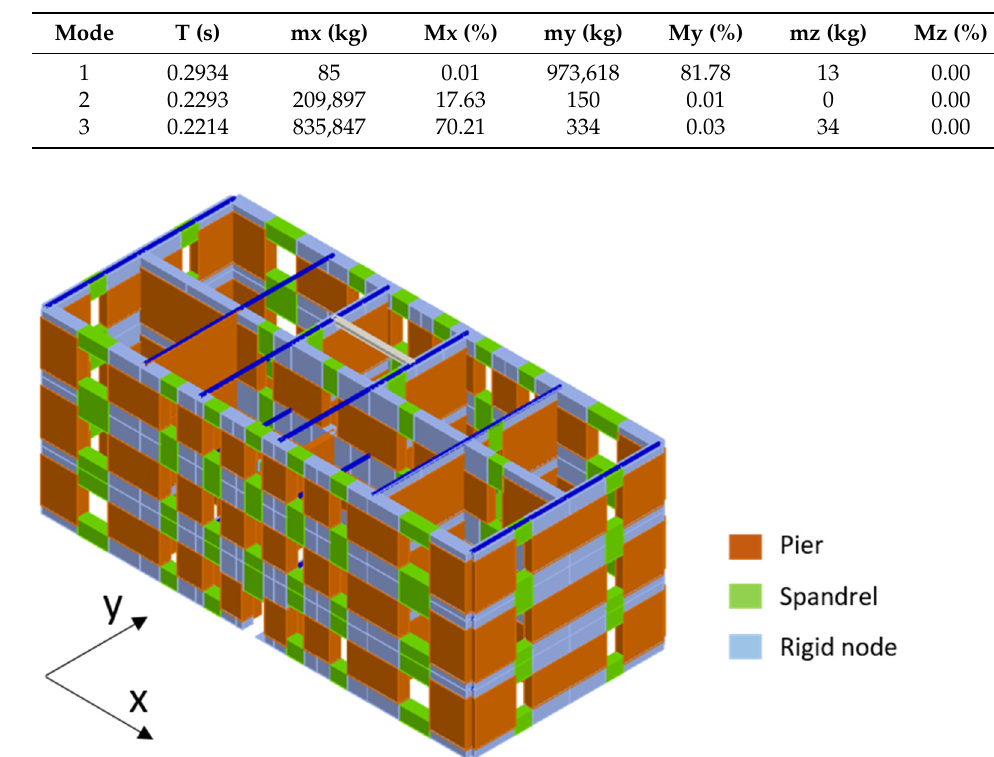
Figure 15. Presentation of 3D model of equivalent frames (macroelements) of the case study in the 3Muri software.